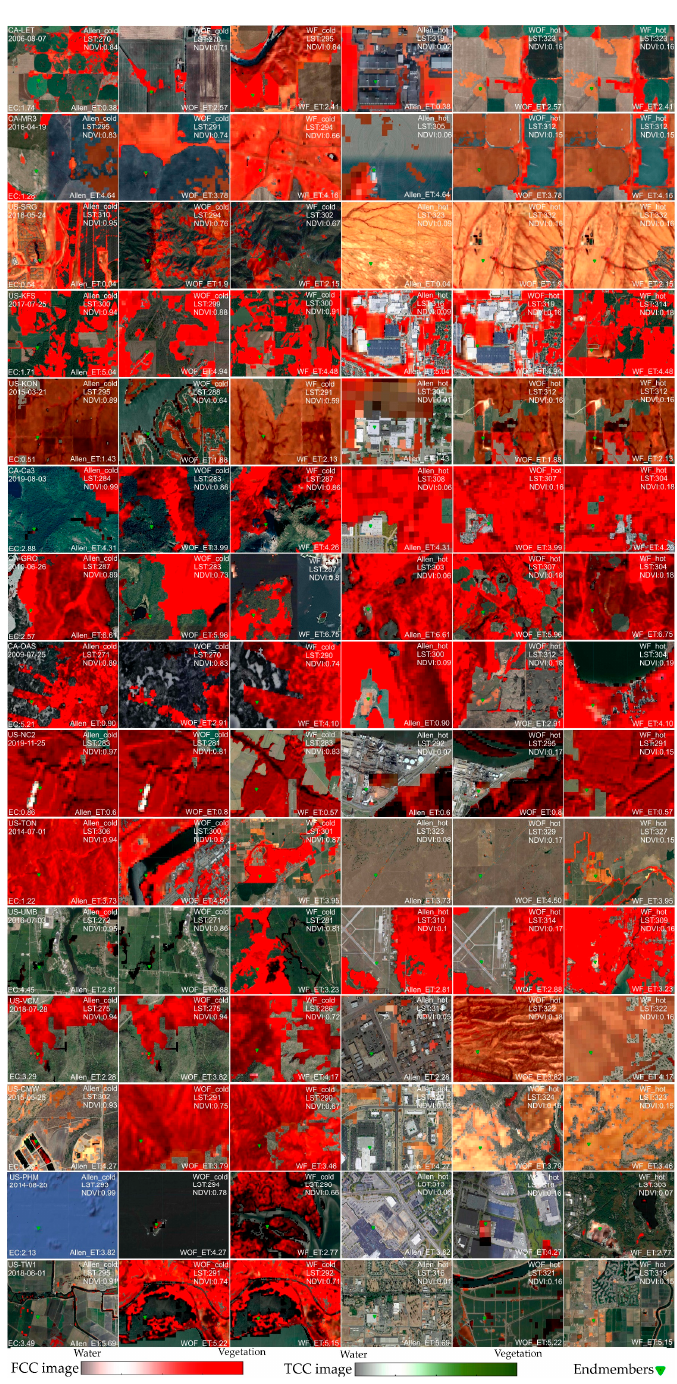
Figure A1. Location and values of cold and hot pixels alongside the statistics of one selected image of non-crop flux towers for the different endmember selection methods, generated using GLDAS meteorological data in SEBAL. Green triangles show endmember location on the intended land cover extracted from FCC, and with the background of Google Earth images. ET estimation performance in each scenario is coded as Allen_ET, WOF_ET, or WF_ET.